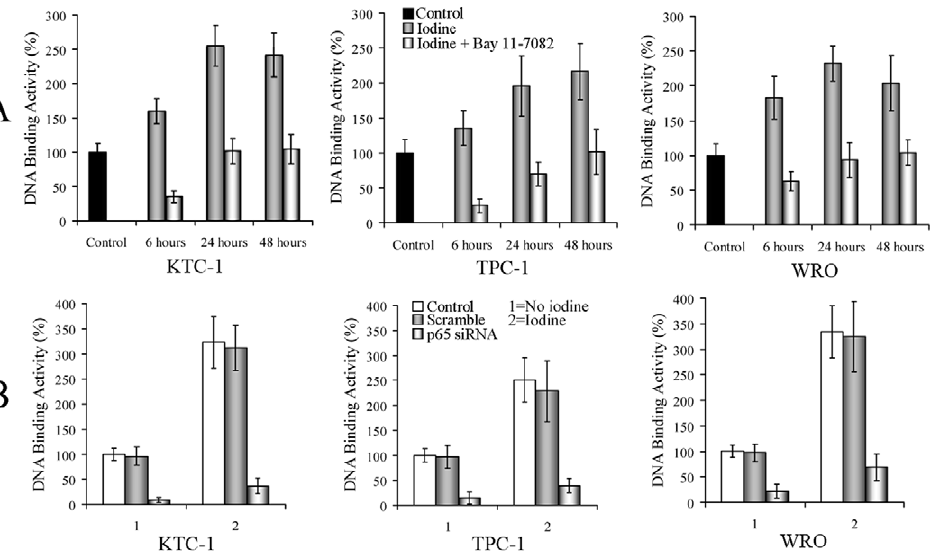
Figure 2. 131 I-induced NF- k B activation can be reduced by Bay 11-7082 or p65 siRNA treatments. (A) DTC cells were treated either with 131 I (20 MBq/ml) or in combination with Bay 11-7082 (5 m mol/L) for 6, 24 and 48 hours. Nuclear extracts were prepared, and DNA-binding assay was done. ( B ) DTC cells were treated with no oligonucleotide control, scrambled oligonucleotides or p65 siRNA transfection. Then cells were exposed to 131 I for 24 hours, and DNA-binding assay was performed. Similar results were obtained in three independent